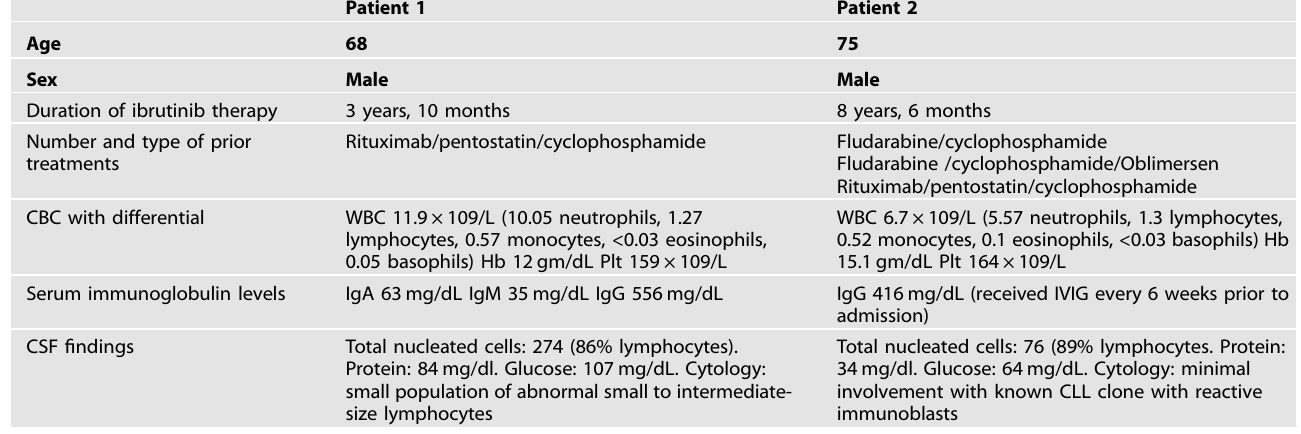
Table 1. Patient characteristics of two patients with CLL who contracted fatal Powassan